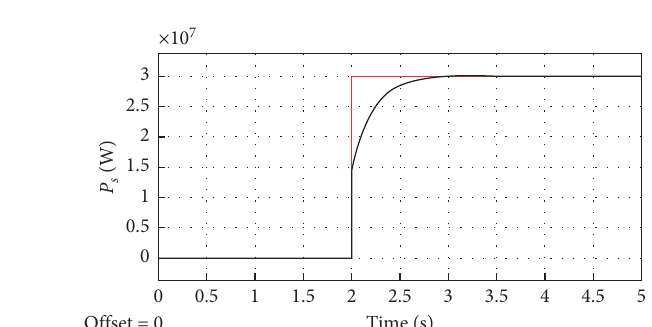
Figure 13: Response waveform of the active power control closed-loop to the step signal.